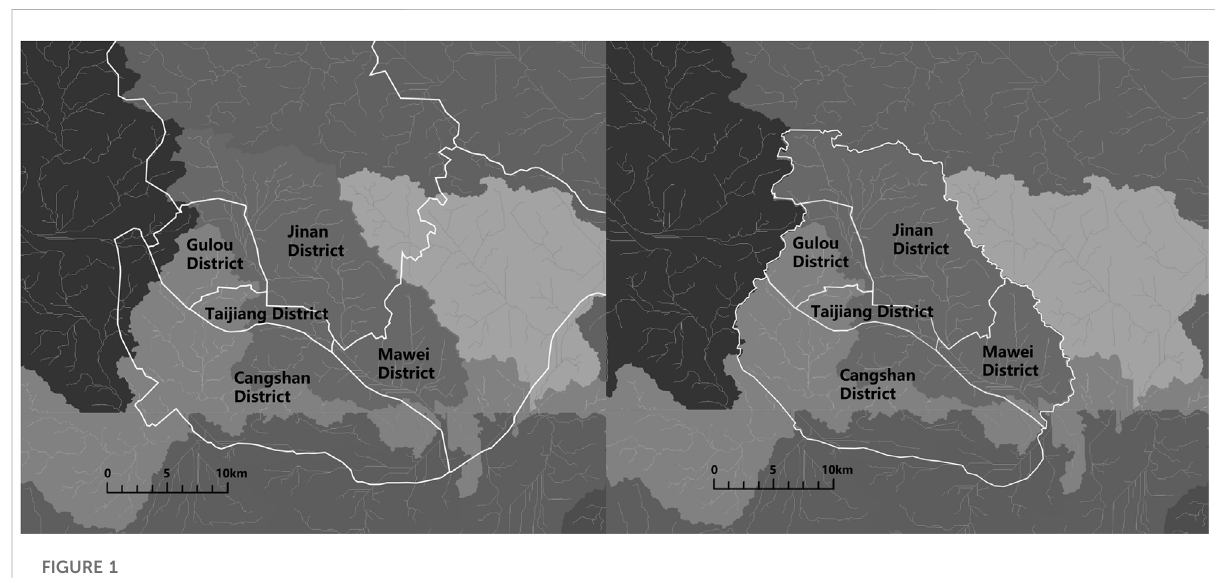
FIGURE 1 Rede fi nition of the central urban area of